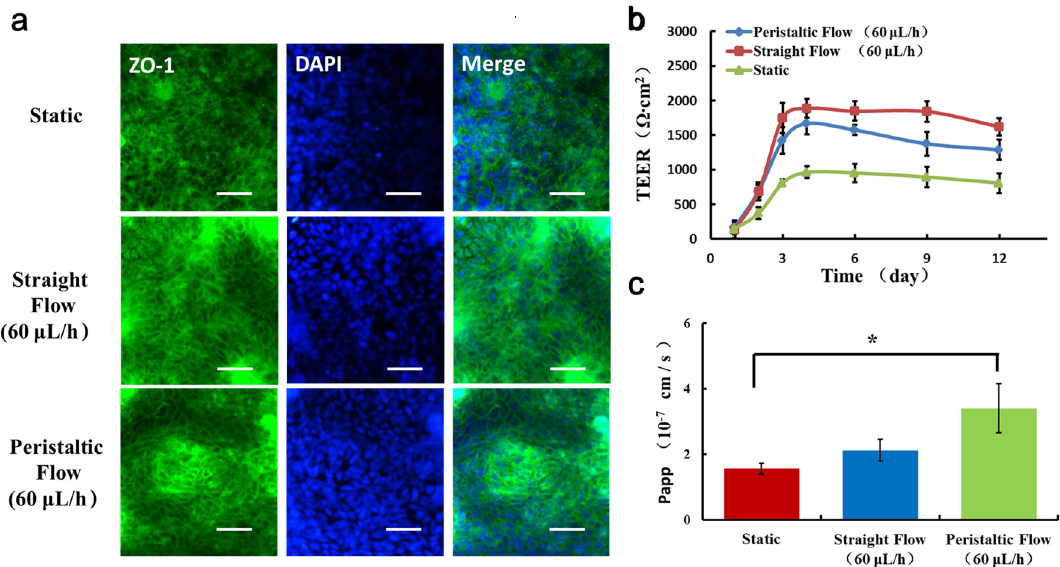
Figure 4. Evaluation of intestinal barrier functions under different flow conditions. ( a ) Immunofluorescent images show the expression of tight junction protein, ZO-1 (green), in the Caco-